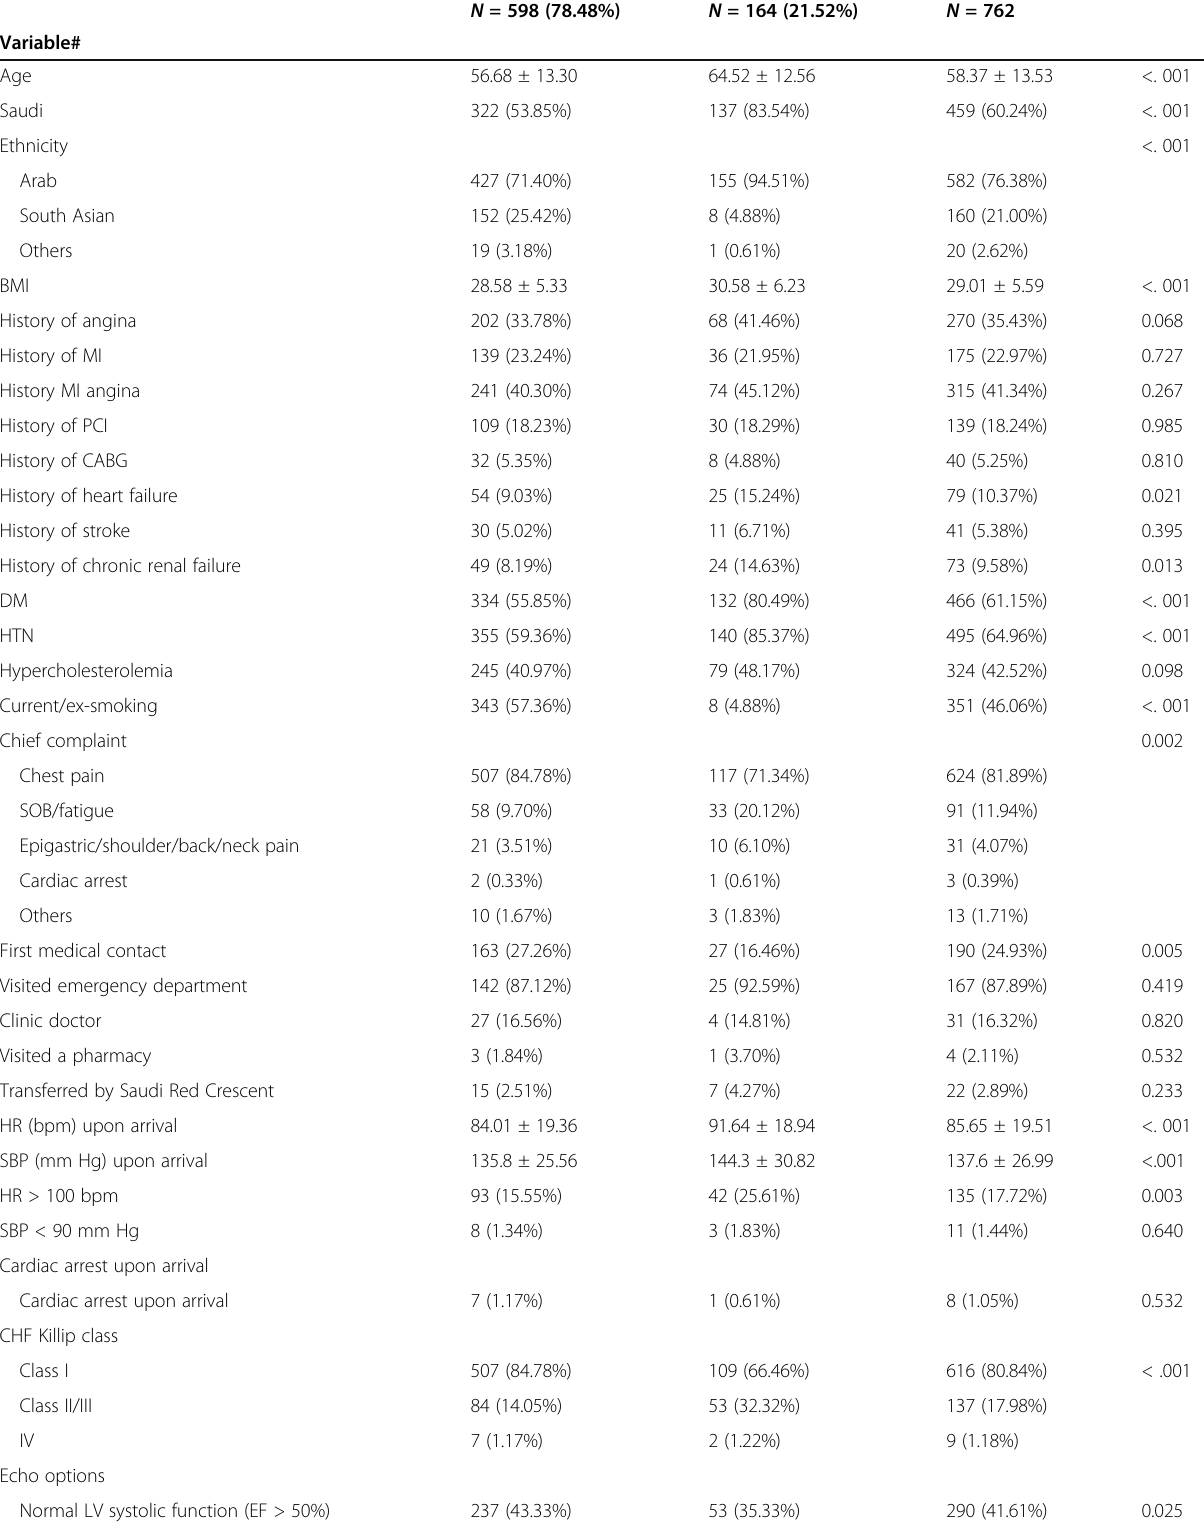
Table 1 Epidemiological data and presentation characteristics of NSTEMI patients by